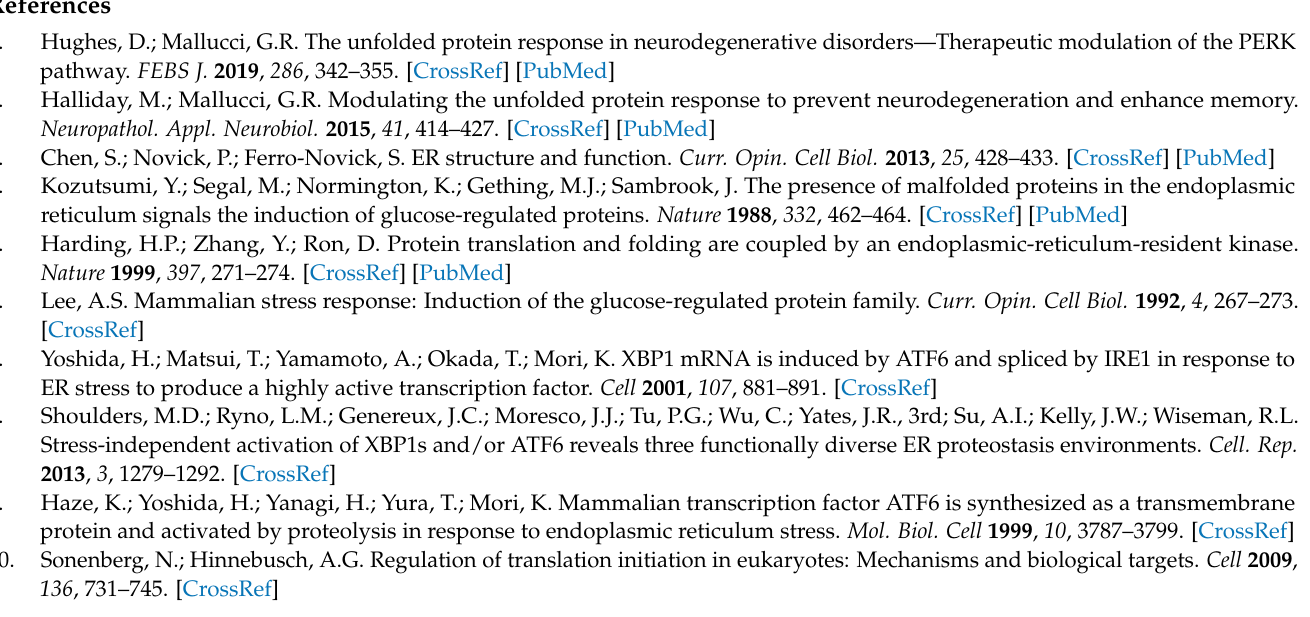
dPerk overexpressing flies (group 1). This table is related to Table 1, Table S14: dPerk-dependent targets differentially regulated by the transcriptome and proteome. Genes that are upregulated at the transcript but not at protein level were analysed (group 2), Table S15: Genes with downregulated transcripts and proteins in dPerk overexpressing flies (group 3), Table S16: uORF analysis of all matched transcripts and proteins in dPerk overexpressing flies. This table is related to Figure 5, Table S17: uORF analysis of group 1 genes. This table is related to Figure 5, Table S18: uORF analysis of group 2 genes. This table is related to Figure 5, Table S19: ClueGO Cellular Component Results: Pathway enrichment analysis of dPerk-dependent targets differentially regulated by the transcriptome and proteome (group 2). This table is related to Figure 7 (left), Table S20: ClueGO Results: Pathway enrichment analysis of dPerk-dependent targets differentially regulated by the transcriptome and proteome (group 2). This table is related to Figure 7 (left), Table S21: ClueGO Results: Pathway enrichment analysis of dPerk-dependant targets downregulated at the transcript and protein level (group 3). This table is related to Figure 7